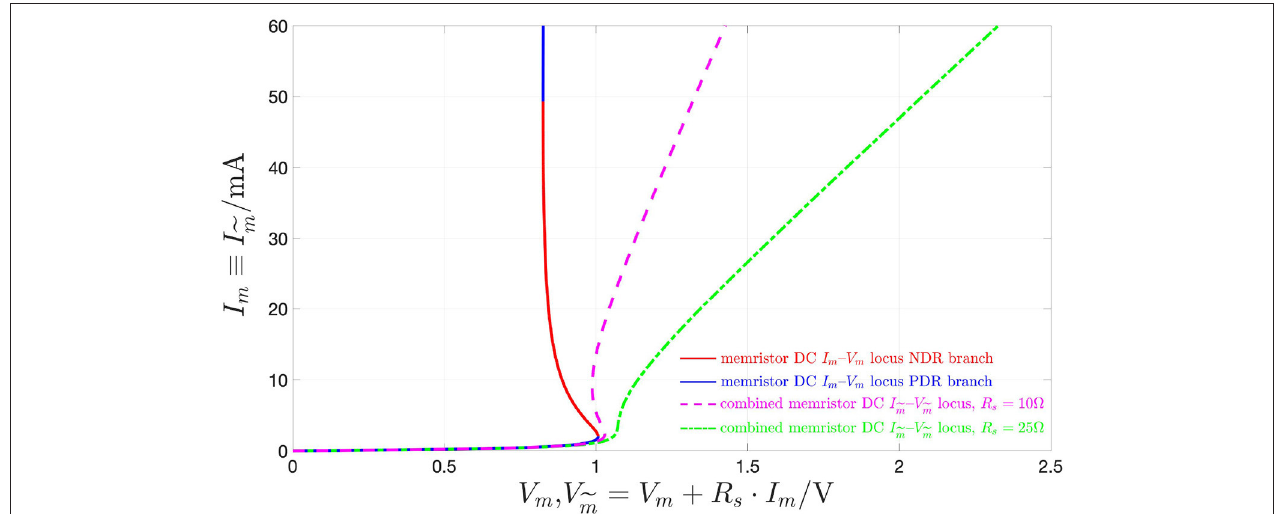
FIGURE 15 | DC current I m ≡ I m –voltage V m = V m + R s · I m loci of the combined memristor for V s = 2.9V and two distinct valued associated to the resistance R s of the series resistor, specifically 10 (cid:127) (dashed magenta curve), and 25 (cid:127) (dash-dotted green curve). The DC I m – V m locus of the threshold switch is also shown for e e reference using the red (blue) color and the solid line style for the NDR (PDR) branch, which, as studied in section 2.2 is unstable (stable) under voltage control. Note 1 1 ) − 1 , is strictly positive only in the scenario where the value of 25 (cid:127) r of the combined memristor, expressed by r Y − 1 that the small-signal resistance s + r − m (0) = ( R − ˜ ˜ = is assigned to R s . In fact, only in this case R s satisfies the condition (15), given that, with reference to Figure 3 , for our threshold switching device e Equation (16), is found to be equal to 21.43 (cid:127) at X =